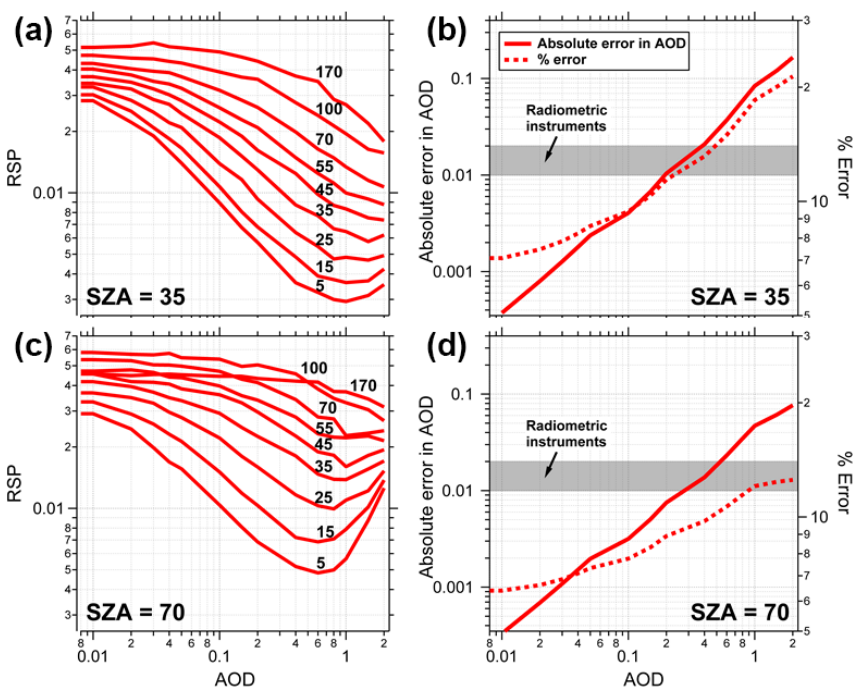
Figure 7. Simulated RSP as a function of AOD for 5 ◦ < SRAA < 100 ◦ at (a) SZA = 35 ◦ and (c) SZA = 70 ◦ . Additional parameters are g = 0.72, SA = 0.05, SSA = 0.98. (b, d) Absolute error in AOD and percentage error calculated with Eq. (3) (see text for details). An AOD error range of 0.01–0.02 is indicated with the gray shadow area. A value of 0.01 is typical of newly radiometrically calibrated